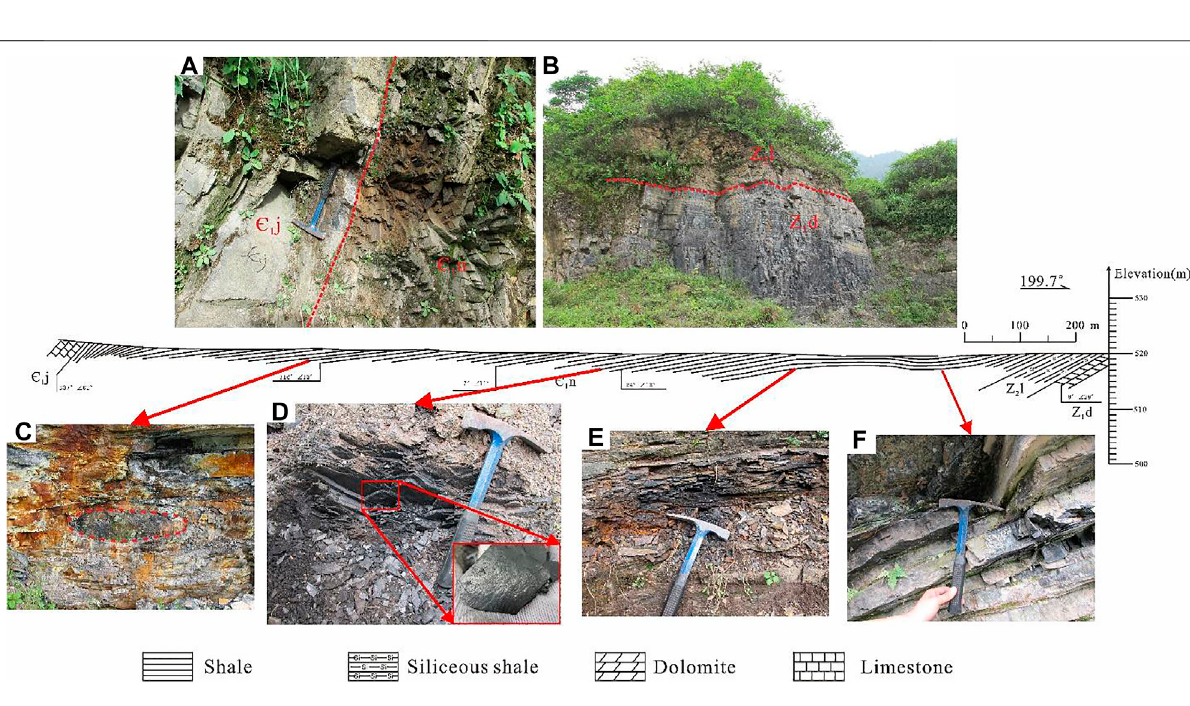
FIGURE 6 | Xiaobao geological section in Cen ’ gong